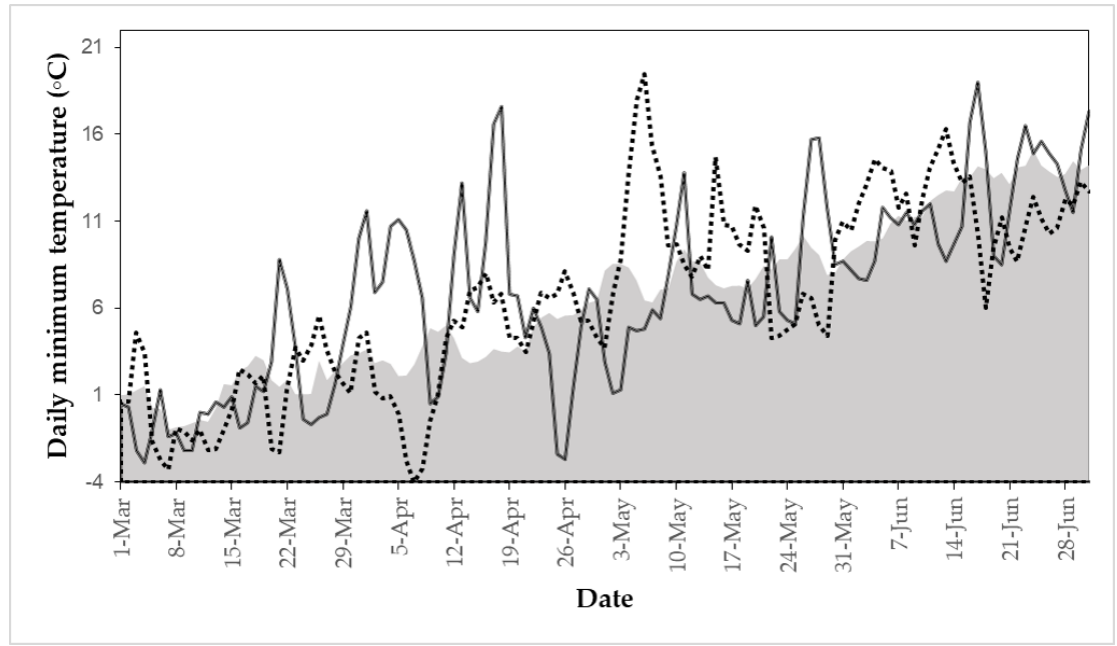
Figure 2. Daily minimum temperature recorded at the Campotenese meteorological station (973 m above sea level, source: Regional Agency for Environmental Protection in Calabria (ARPACal)). Continuous line: values recorded during 2016; dashed line: values recorded during 2015; grey area profile: average values from 2002–2015. The low percentage of missing data allowed us to obtain a reliable reconstruction of the long-term averages in the study period.